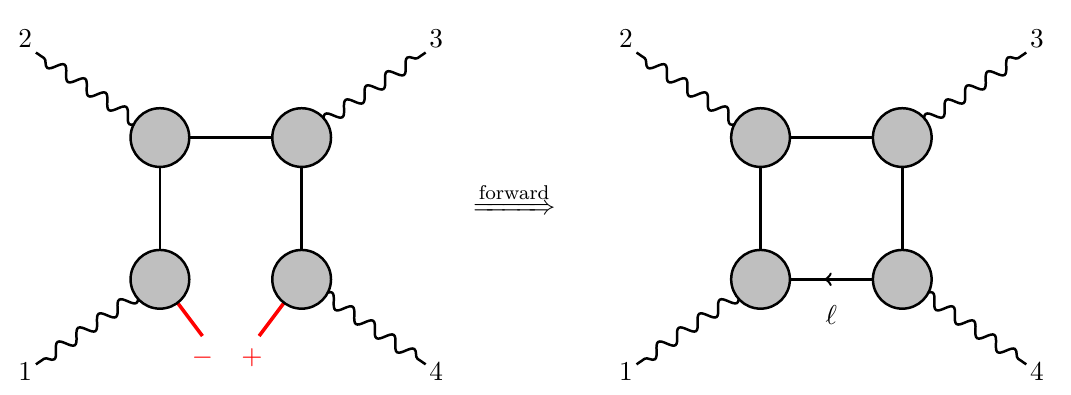
Figure 2 . The curvy line means the particle momentum is restricted in 4D (as parametrised in (3.1)), while the particle with the solid line still remains in 6D kinematics. The red line represents the forward-limit particle pair with 6D kinematics, which is understood as loop